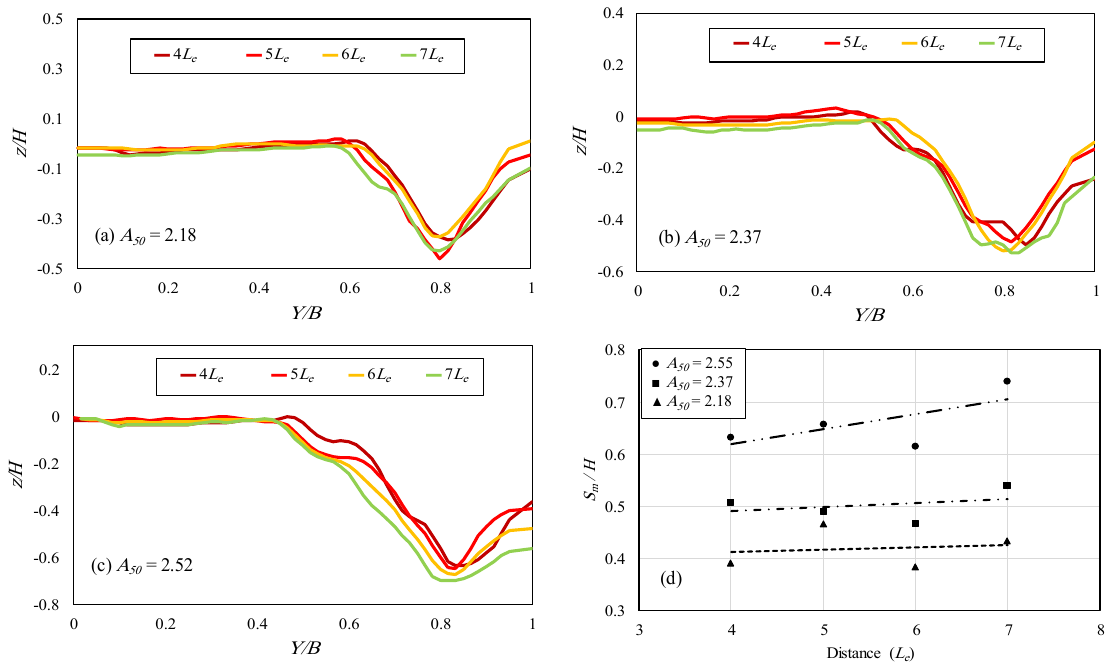
Figure 7. Cross sections of maximum scour depth and variations of maximum scour depth ( d ) at different distances and hydraulic conditions. ( a ) A 50 = 2.18 ( b ) A 50 = 2.37 ( c ) A 50 = 2.52. Table 3. Characteristics of maximum scour depth at different tests.